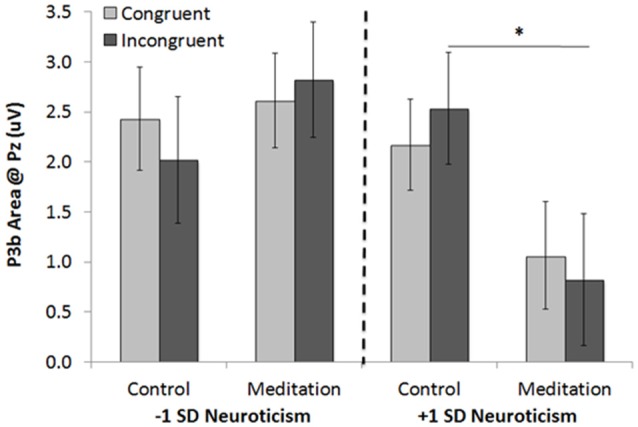
The 3-way interaction between neuroticism, meditation/control tape condition, and trial type in Study 2 on P3b areas at Pz (Note: positivity is plotted up for ease of interpretation; higher P3b amplitudes will thus be presented as taller bars). *p < 0.05.